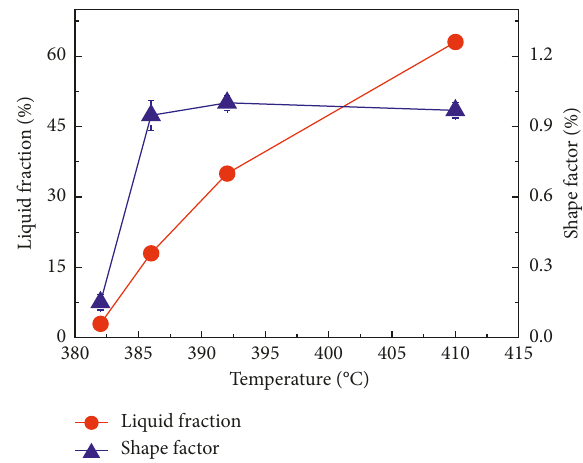
Figure 6: The variation in the shape factor of the solid grains and the liquid fraction as a function of the